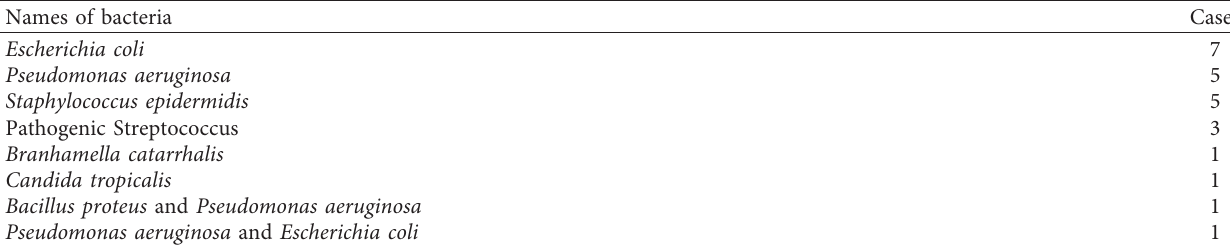
Table 2: Bacterial culture results from secretions of 24 PCFs.